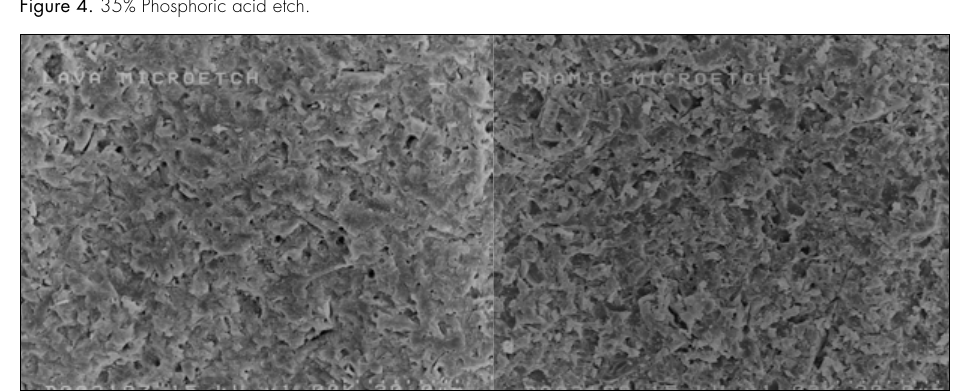
Figure 5. 50 µ Aluminum oxide microetching.